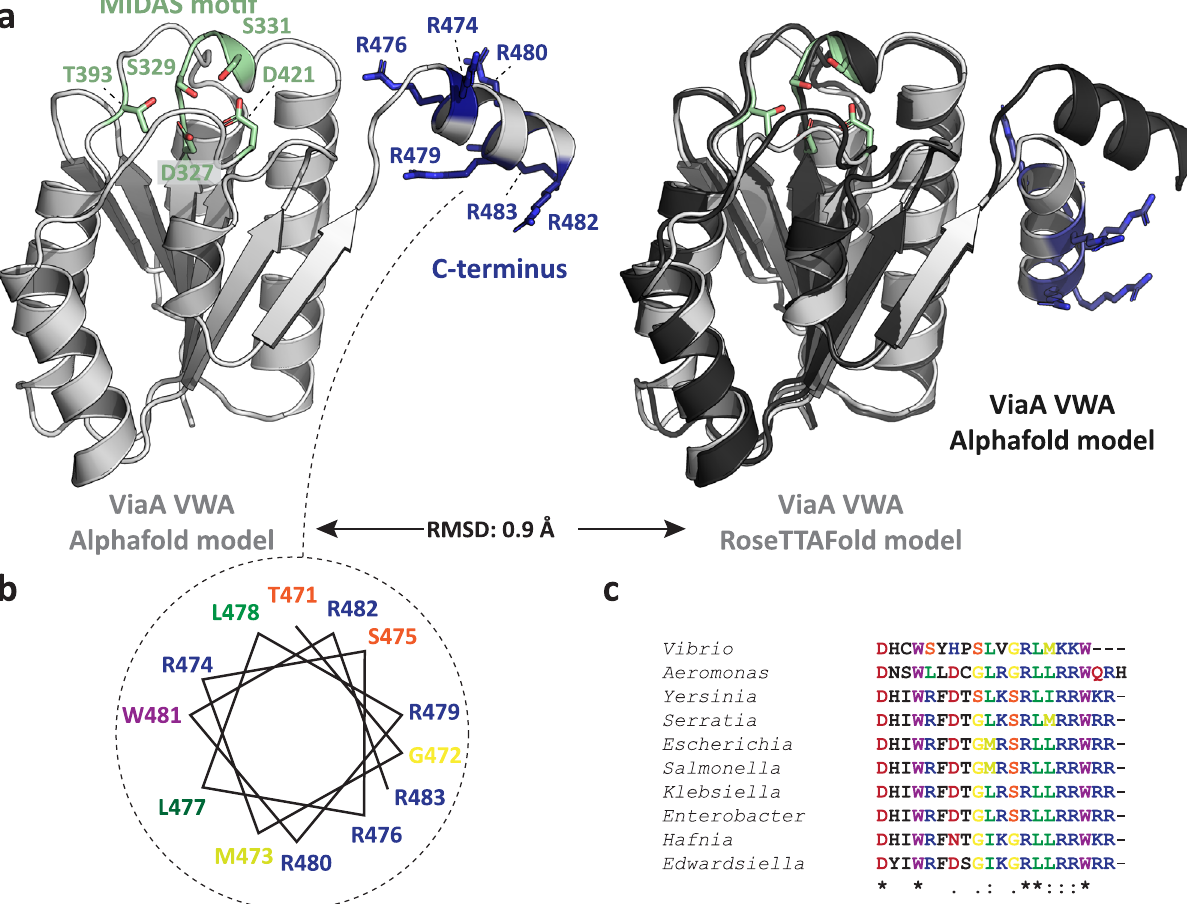
Fig. 5 | Structure and sequence-basedpredictionoftheViaAlipid binding site. a Cartoon presentation of Alphafold (left, light grey) and RoseTTAFold (right, light grey) structural predictions for the ViaA VWA domain (residues 320 - 483). The MIDAS motif (green) as well as Arginine residues in the C-terminal helix (dark blue) are annotated and shown as sticks. The Alphafold and RoseTTAFold models are shown superimposed on the right in dark and light grey respectively. The Aphafold prediction of E. coli ViaA can be found at https://alphafold.ebi.ac.uk/entry/A0A828TYA7. The majority of the